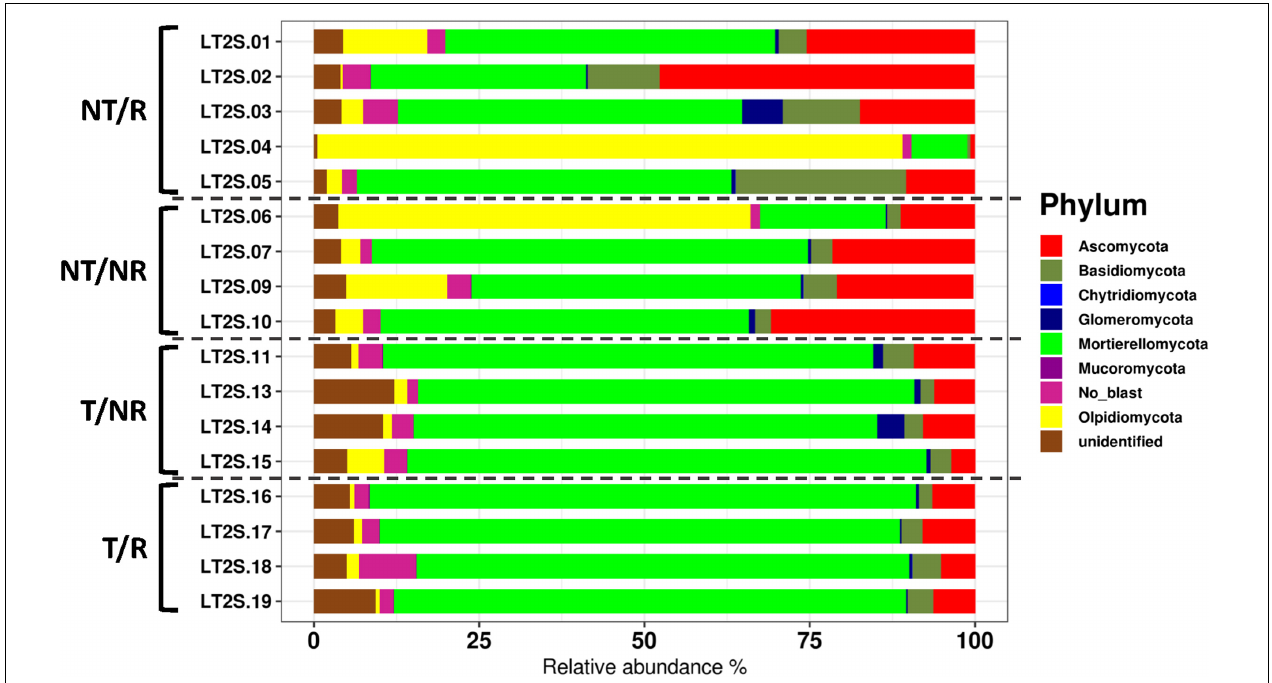
FIGURE 1 | Barplot showing the fungal diversity at the phylum